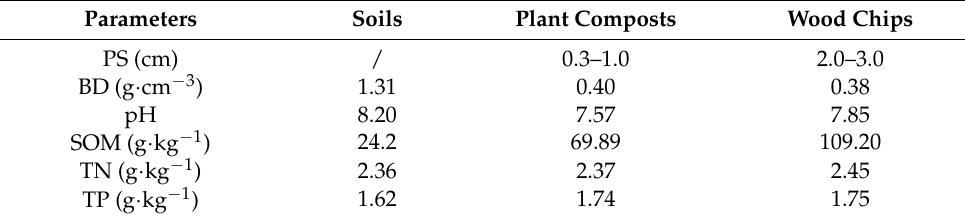
Table 2. Characteristics of the soils, plant composts and wood